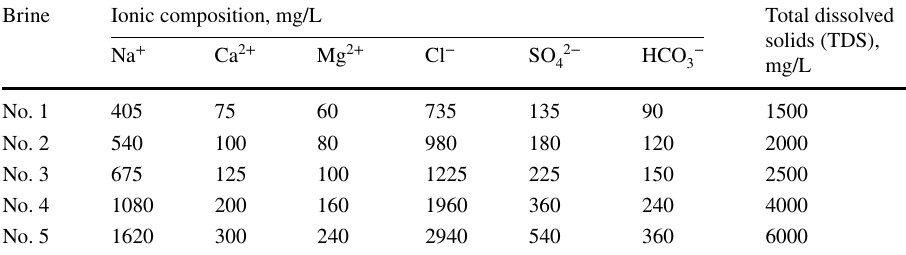
Brine Ionic composition, mg/L